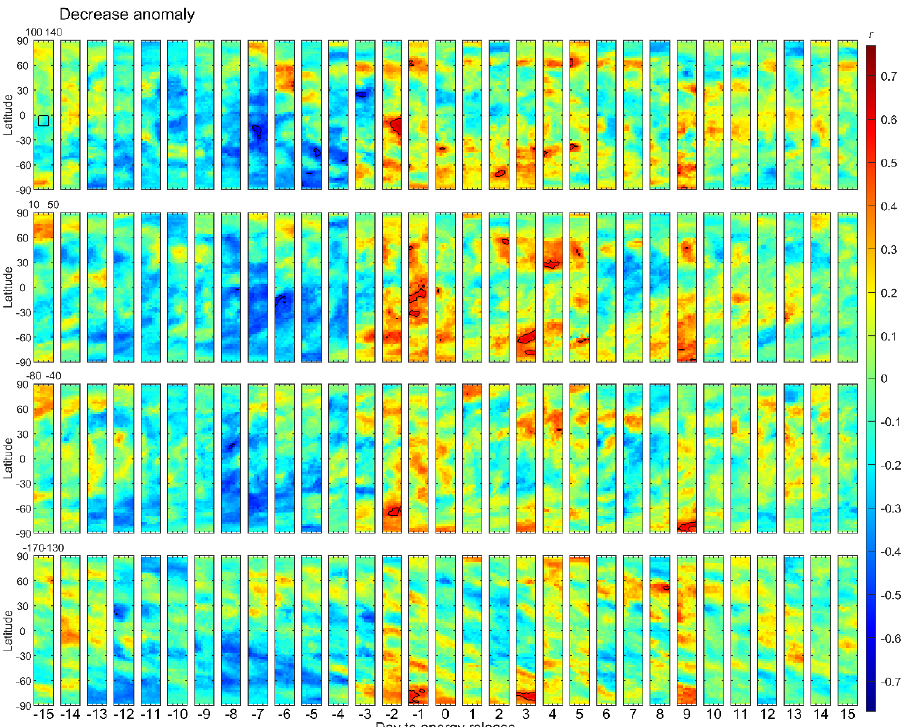
Figure 11. Distributions of the correlation coefficient of the TEC decrease anomaly for the declustered samples with energy releases ≥ M 5.5 within Region A and without outliers. Data are removed using the Dst index.